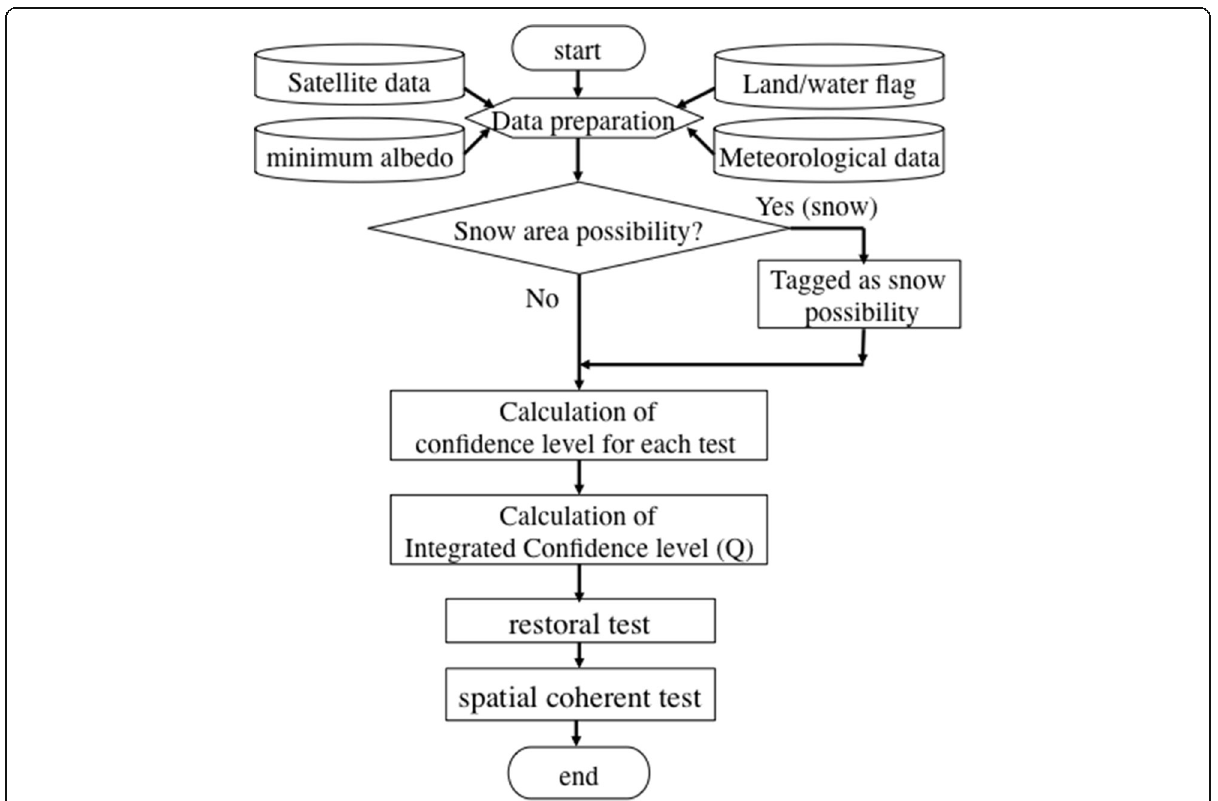
Fig. 4 Flow chart for the cloud/clear discrimination algorithm